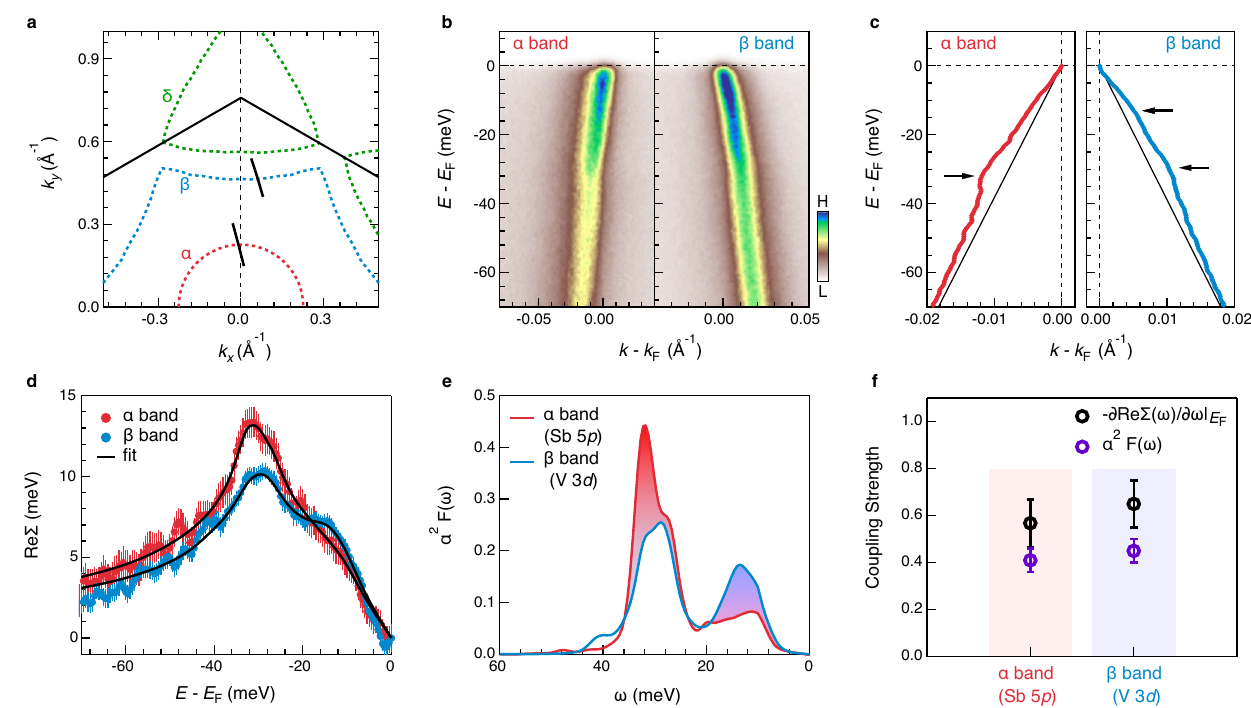
converted to energy by multiplying velocity of bare band. The black lines are the Re Σ ( ω )reproducedbymaximumentropymethod. e ExtractedEliashbergcoupling functions α 2 F ω ð Þ forthe α and β bands. f λ p,d estimatedfrom α 2 F ω ð Þ (purplecircles) and λ dev de fi ned by the slope of Re Σ ( ω ) at E F (black circles). The error bars are determined by the standard deviation of the Re Σ ( ω